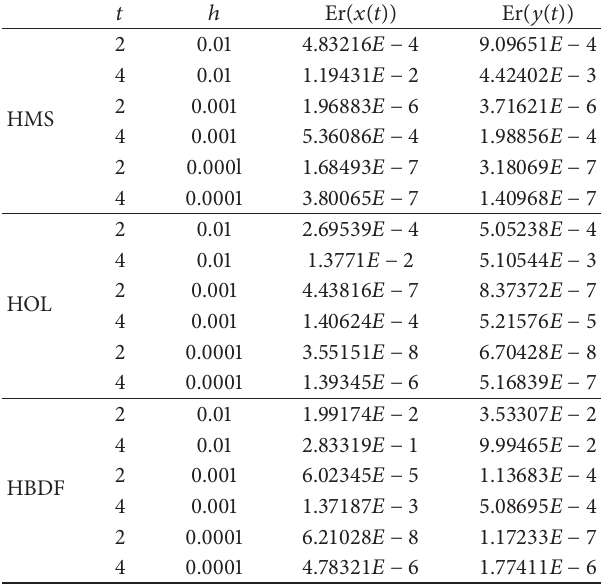
Table 1: The errors of solutions for the first